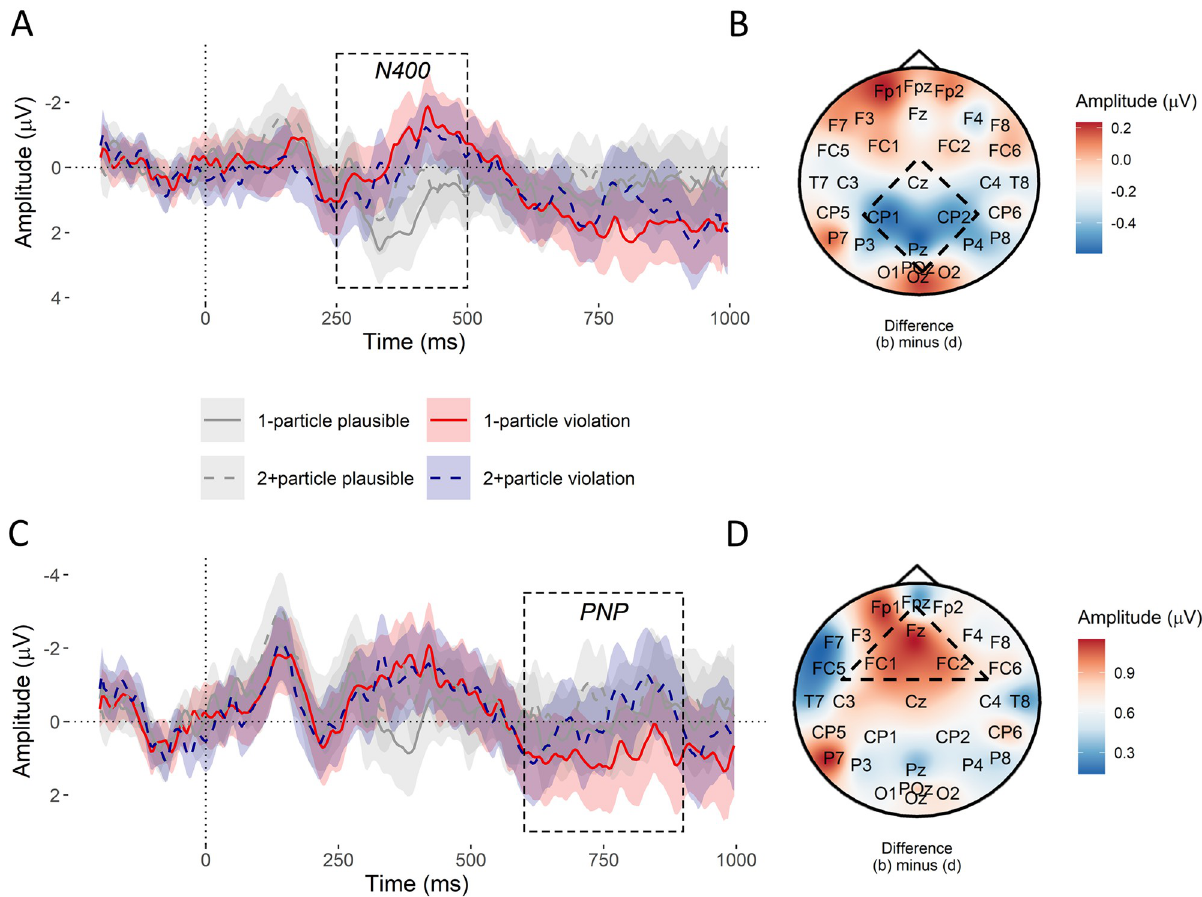
Fig 1. Experiment 1: ERP results. A . Average amplitude following stimulus onset shows an N400 in the posterior region of interest (Cz, CP1, CP2, Pz) for violations of both the 1-particle (red) and 2+particle (blue) conditions relative to the plausible (grey) conditions. Ribbons show 95% confidence intervals. These intervals were calculated by fitting a linear model of the form amplitude � condition with by-subject and by-item intercept adjustments at each timestep of the ERP recording and extracting the standard error of the relevant conditions. The analysed N400 time window is overlaid. B . A voltage subtraction map of the N400 time window shows a small difference in amplitude between the 1-particle (a) and 2+particle (b) conditions in the region of interest (dashed square). C . A PNP for the 1-particle condition is seen in the anterior region of interest (Fz, FC1, FC2) 600–900 ms window after stimulus onset, but not in the 2+particle or plausible conditions. Ribbons show 95% confidence intervals. D . A voltage subtraction map of the PNP time window suggests amplitudes in the 1-particle condition were more positive in the mid-frontal region (dashed triangle) than in the 2+particle